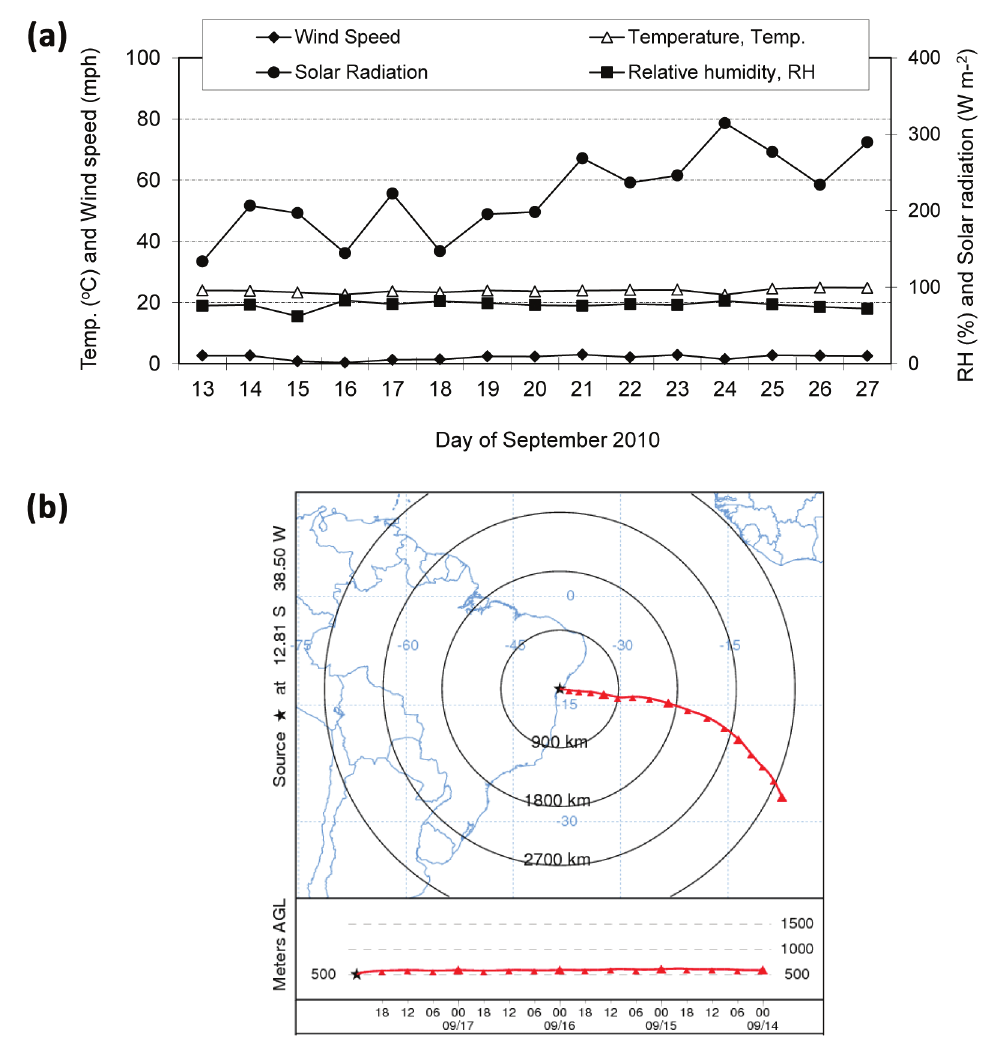
Fig. 2 - Time trends of meteorological parameters (a) and backward trajectory (b) during sampling period at